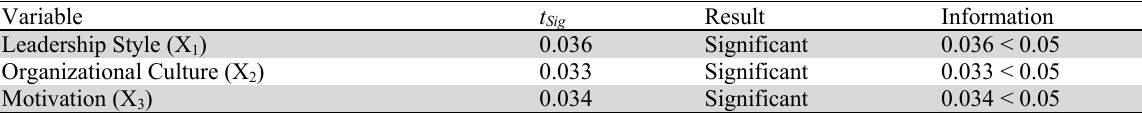
Calculation Results of the t